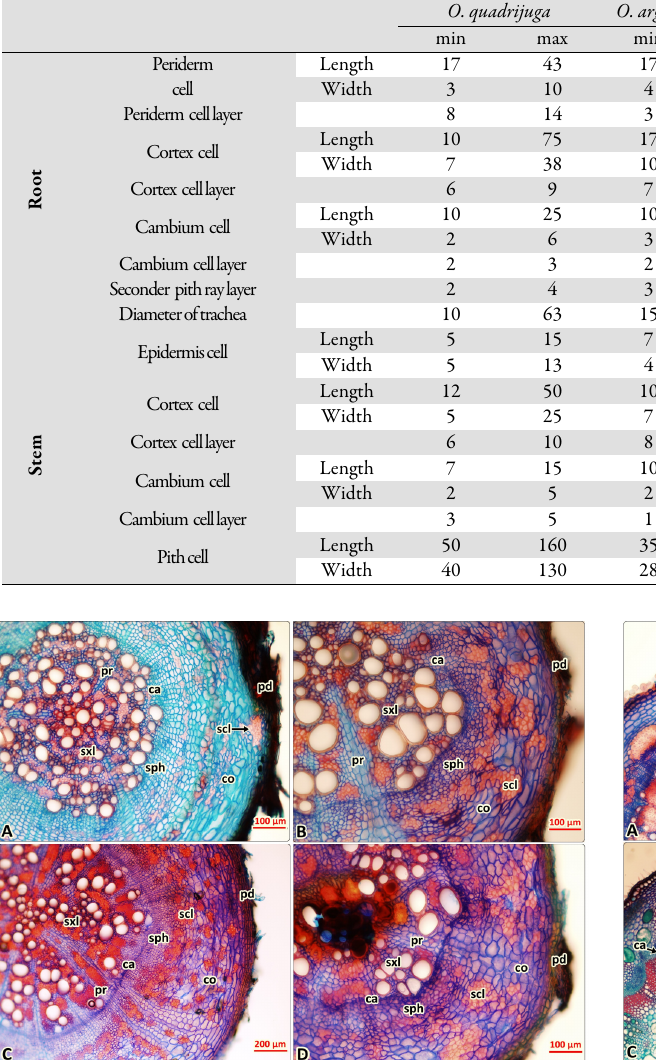
Table 2. The length and width measurements of cells (µm) and cell layer number in root and stem of examined Onobrychis taxa